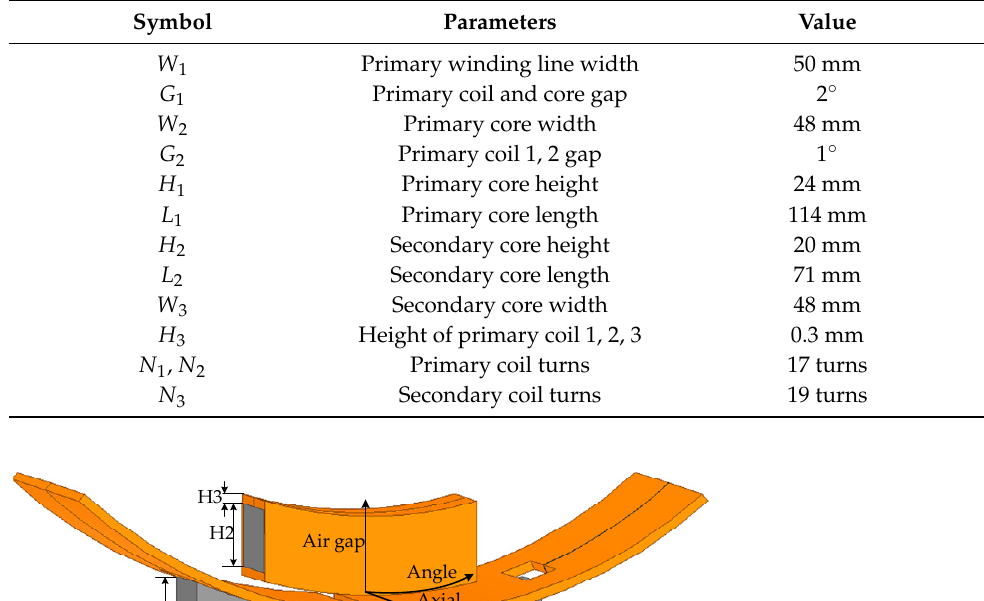
Table 1. Parameters of the MC.